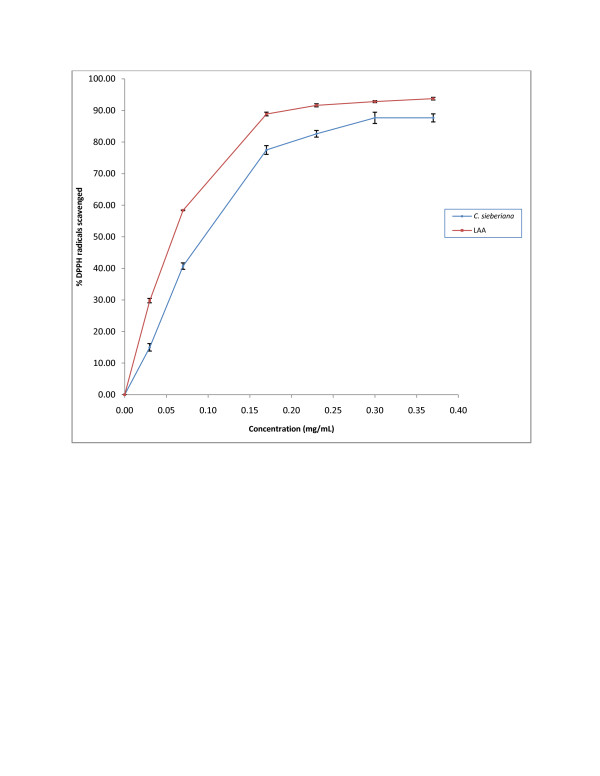
DPPH radical scavenging activity ofC. sieberianaroots bark extract. L-ascorbic acid (LAA) was used as a reference compound. Results are means ± SEM of n = 3.